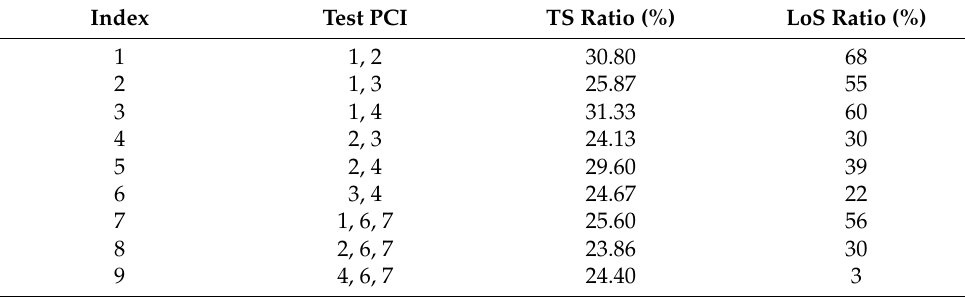
Table 4. Selected scenario